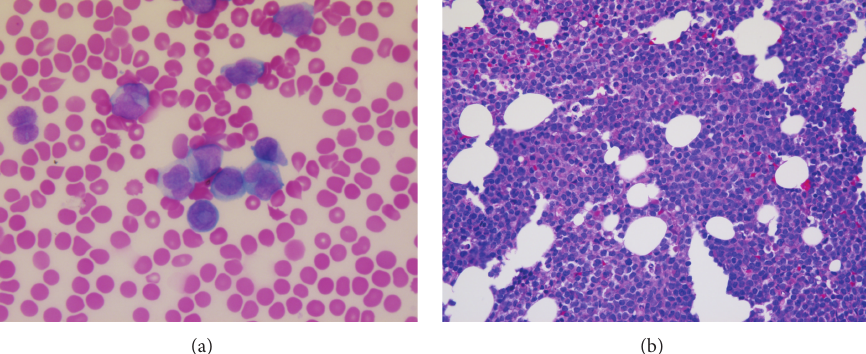
Figure 1: (a) Peripheral smear revealing blasts that contained bilobed nuclei with very fine granules (100x). (b) Bone marrow biopsy showing a hypercellular marrow with 64% blasts and decreased trilineage hematopoiesis (40x).